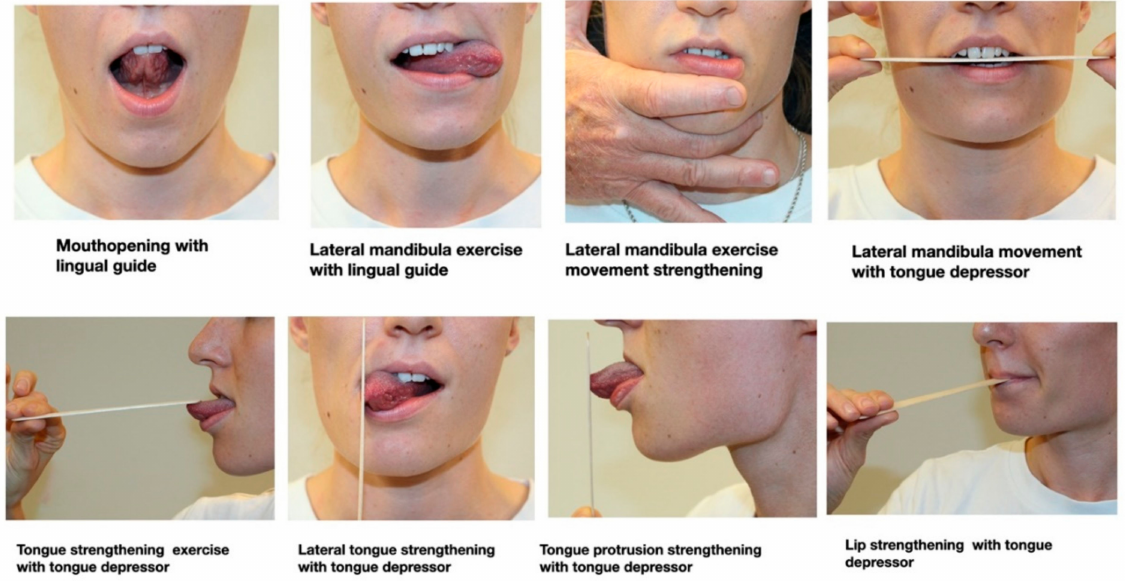
Figure 6. Face motor-training